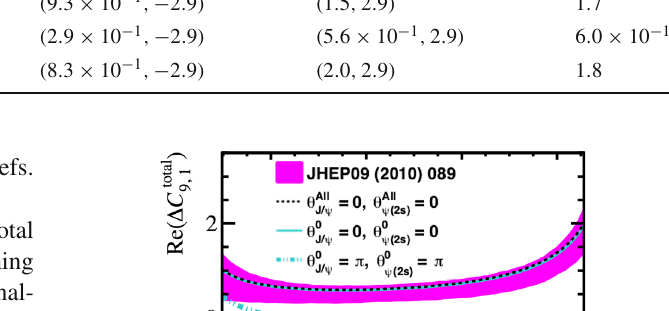
Table 1 Summary of the input values used to model the non-local amplitude components G λ . The input values rely on measurements given in Refs. [20,29–32,40–44]. The phases